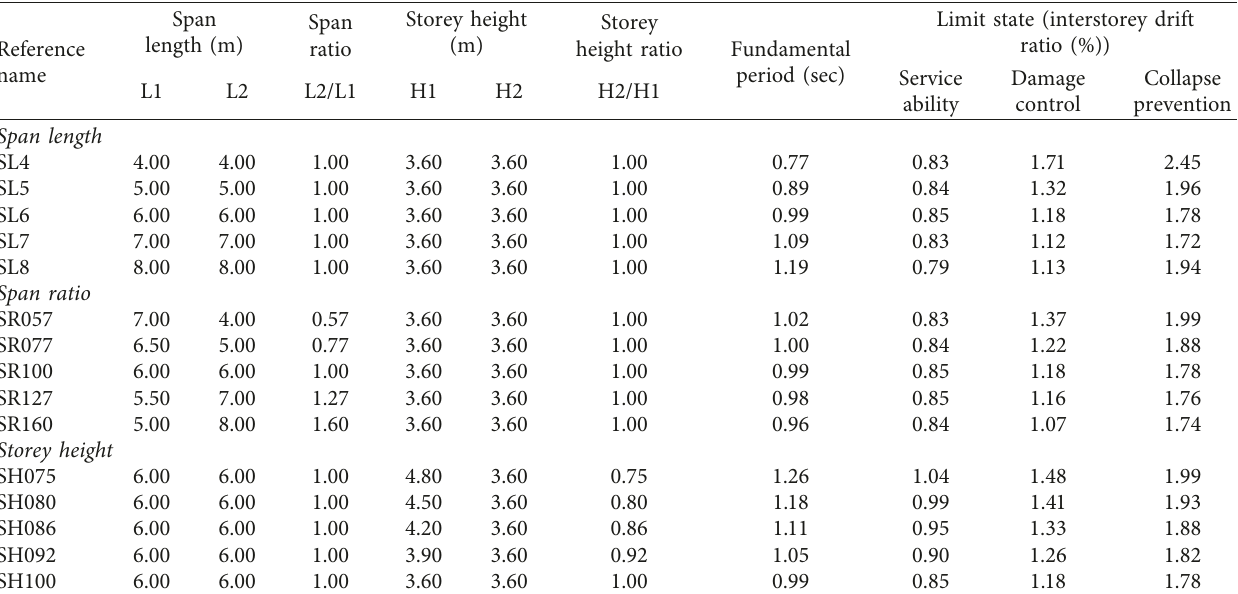
Table 1: Details and limit states of the selected RC